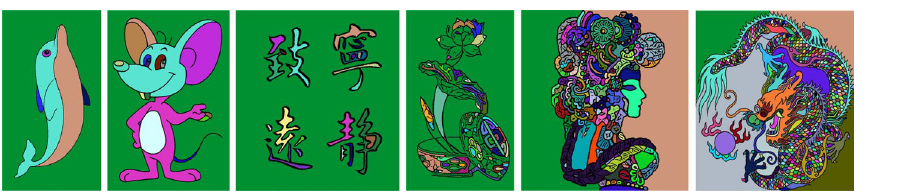
Figure 9. Images of regional division results.